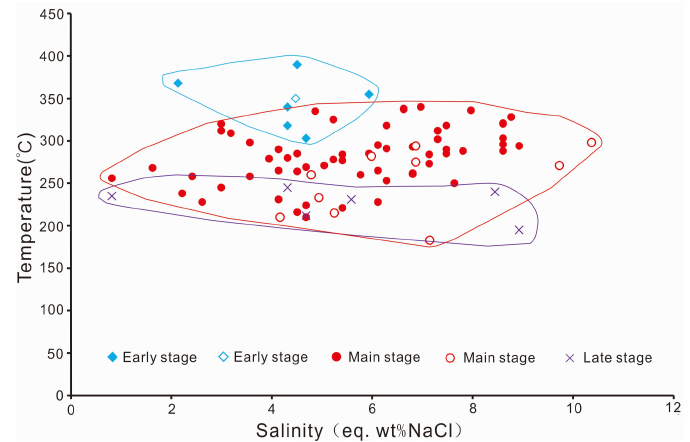
Figure 11. The temperatures ( ◦ C) of the total homogenization temperatures (T hTOT ) versus salinity (wt% NaCl eq.): The solid and hollow signs represent the H 2 O–CO 2 inclusions and aqueous inclusions,